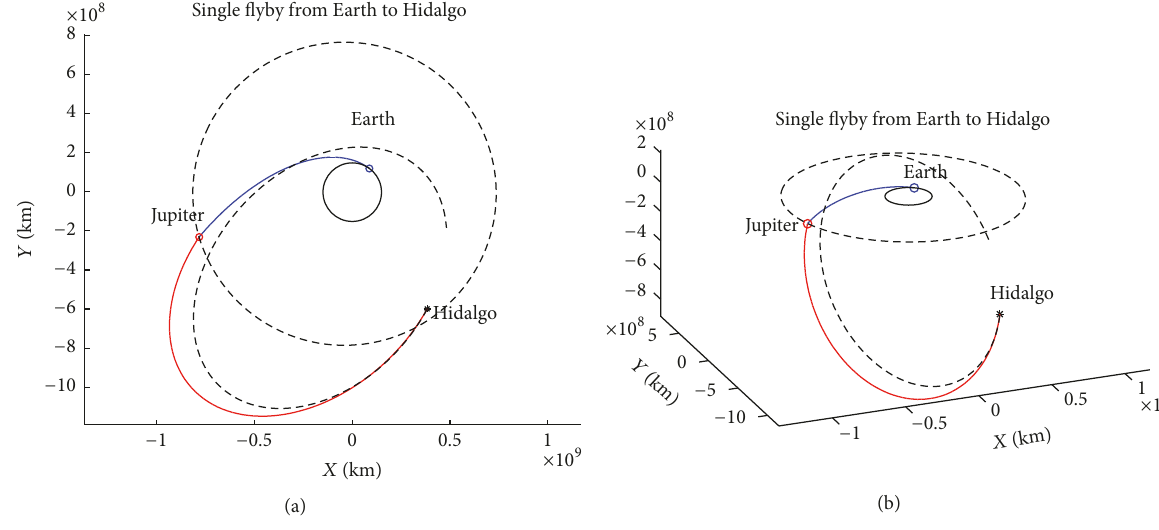
Figure 9: Single flyby trajectory simulation results.